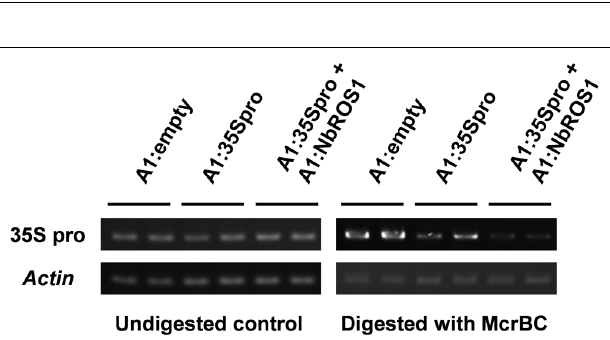
FIGURE 3 | Cytosine methylation status of CaMV 35S promoter analyzed by bisulfite sequencing. Cytosine methylation status of the CaMV 35S promoter in plants infected with (A) A1:empty that lacked an insert, (B) A1:35Spro, and (C) both A1:35Spro and A1:NbROS1. The percentages of methylcytosine are shown. Numbers below the line indicate the relative nucleotide positions from the transcriptional start site. Horizontal black lines indicate the targeted region. Red, green, and blue lines indicate frequencies of methylcytosine at the CG, CHG, and CHH sites,